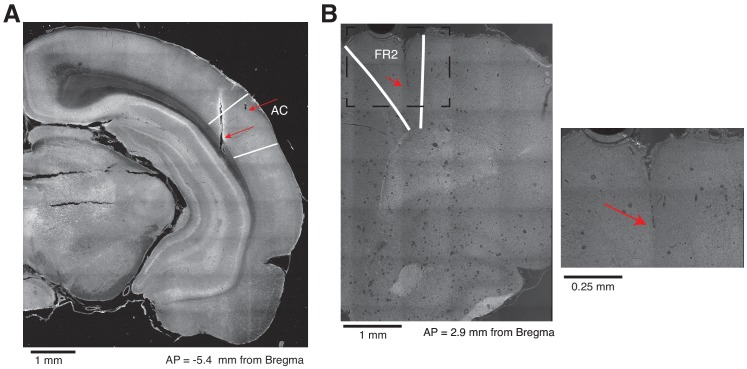
Histological placement of electrodes in AC and FR2.(A) Example of electrode tracks and electrolytic lesions in AC. The white lines represent the borders of AC. (B) Example of an electrode track in FR2. The white lines represent the borders of FR2. Left, section imaged at 10X. Right, the same section imaged at 40X.